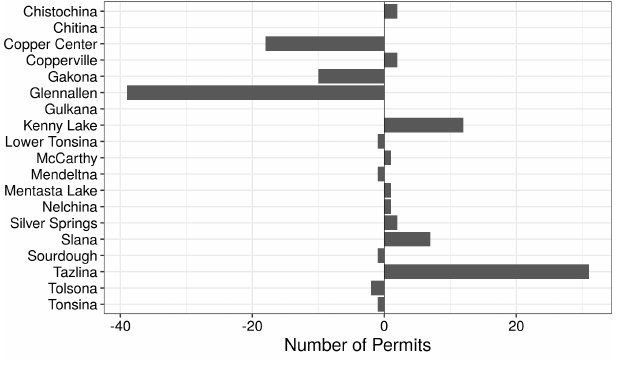
Fig. 7 . Change in number of fish wheel permits returned by community,